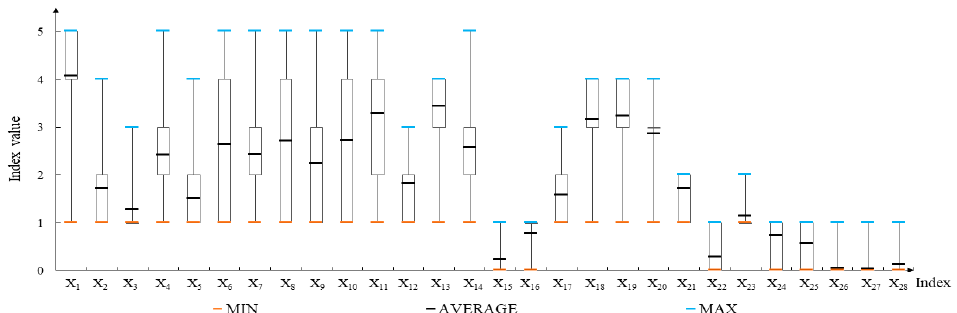
Figure 3. Statistics of the independent variables influencing farmers ′ willingness to migrate to urban areas.